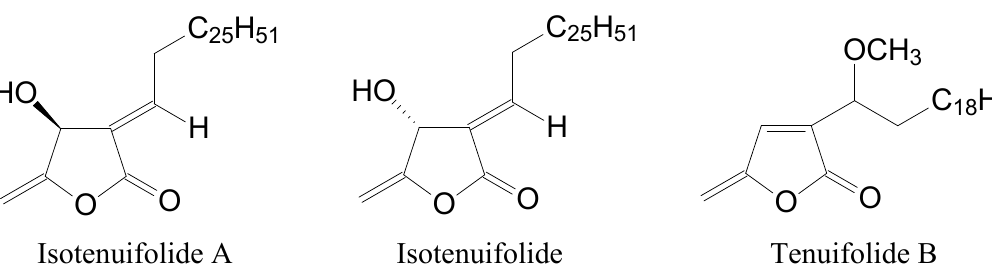
Figure 1. The chemical structures of isotenuifolide A, isotenuifolide and tenuifolide